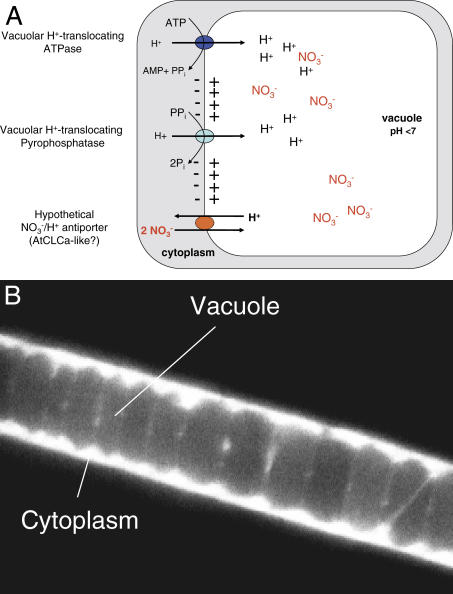
Energetic Vacuolar Concentration of Nitrate by Beggiatoa Sp.(A) Hypothetical model of nitrate accumulation in the vacuole of Beggiatoa.
(B) Beggiatoa filament stained with the cationic, lipophilic dye rhodamine 123. Rhodamine 123 accumulated in the cytoplasm but was excluded from vacuoles, indicating the presence of an electric potential (inside positive) over this membrane.